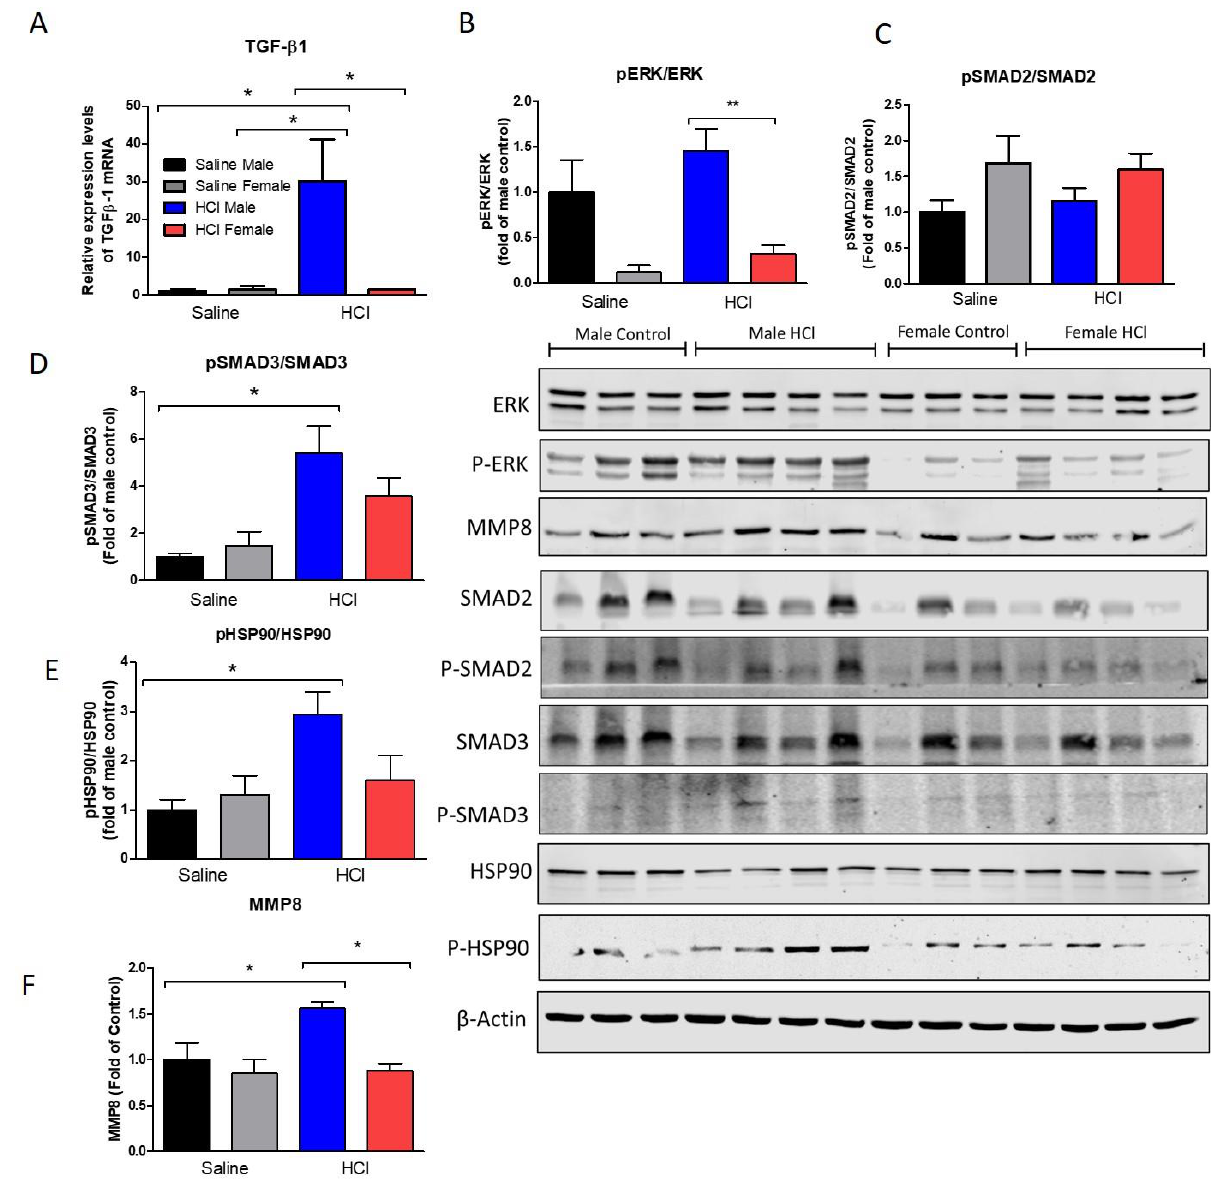
Figure 4. Intracellular pathways of TGF- β 30 days after HCl instillation. ( A ) Male mice treated with HCl displayed increased gene expression levels of TGF- β 1 compared to saline or females. ( B ) Male animals showed high levels of p-ERK compared to females 30 days after HCl instillation. ( C ) The phosphorylated form of Smad3 was significantly increased in males but not in female animals. ( D ) Heat Shock Protein 90 activation (pHSP90) increased only in males. ( F ) Matrix metalloproteinase levels were higher in males ( E ). TGF- β 1 mRNA expression levels were measured by real-time qPCR and normalized to β -actin. Band density was normalized to β -actin and plotted as fold of control. Means ± SEM; ** p < 0.01, p < 0.05 with one-way ANOVA and Tuckey’s, n = 3 – 4.